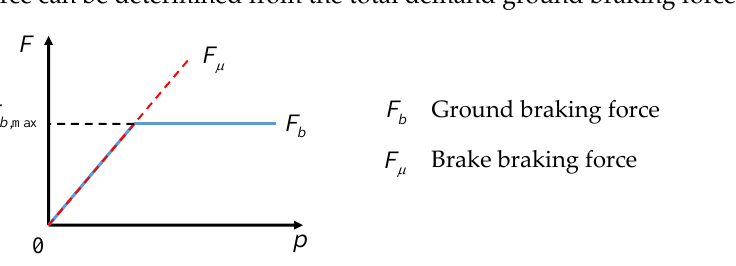
Figure 16. Relationship between ground braking force and brake braking